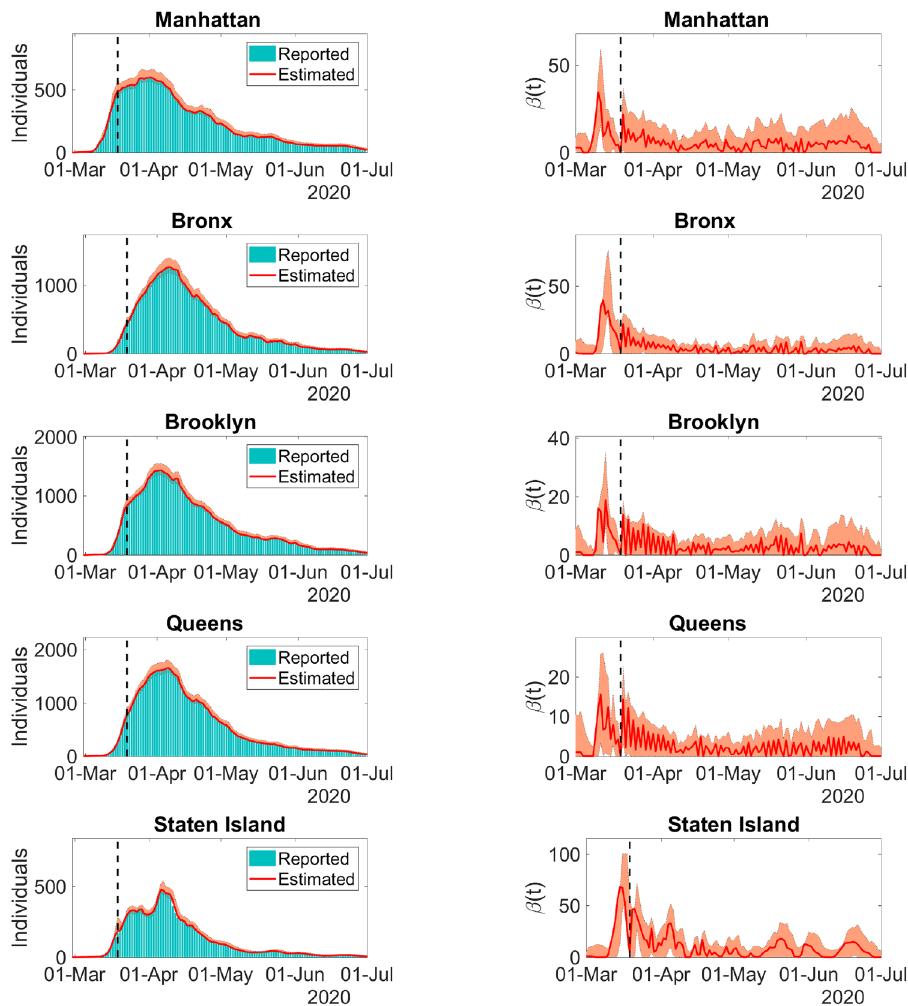
Figure 3. Left column: Model predictions and reported daily new infections for each NYC borough. Right column: Time-dependent transmission parameter estimated for the NYC each boroughs. Solid lines represent the model best fit predictions, and bars depict the 7-day moving average of the number of reported cases. Dashed lines divides the spread regime into uncontained and contained. The filled envelopes are the 90% CIs. The time series is from 29-Feb-2020 to 01-July-2020. Figure generated with MATLAB R2019b (mathworks. com).